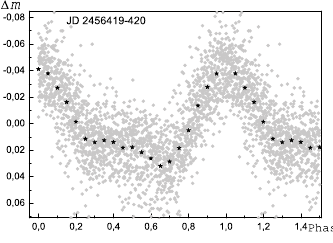
Figure 5: V light curve of superhumps.